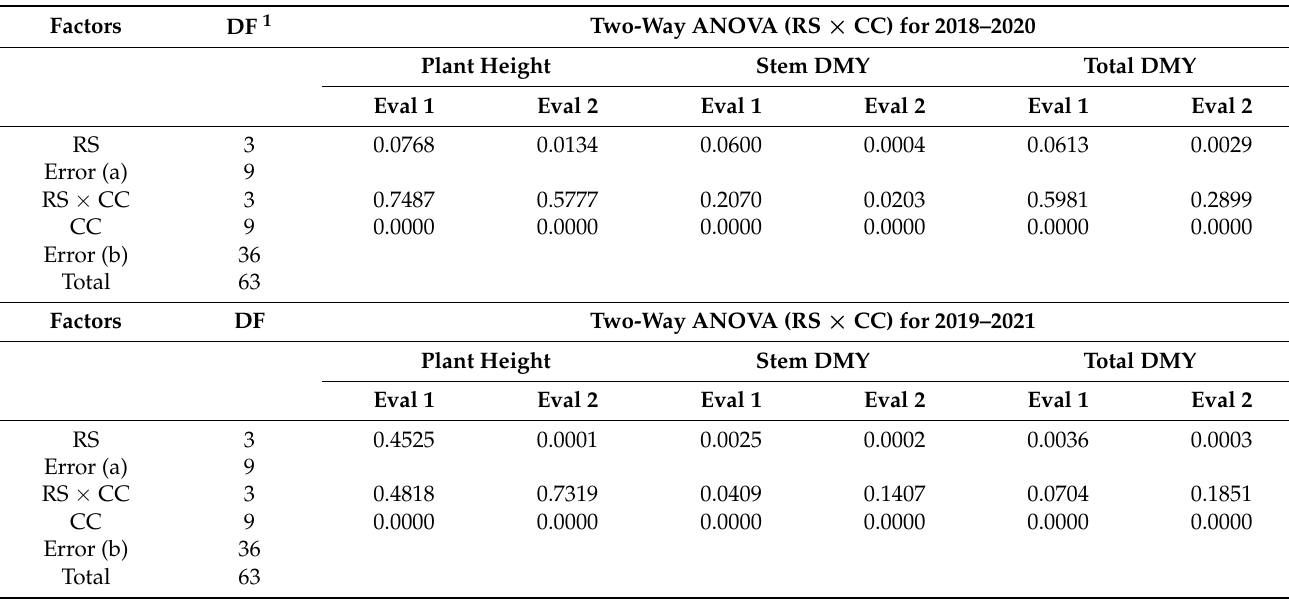
Figure 3. Sulla ( a ) plant height (cm), ( b ) stem DMY (t ha − 1 ), and ( c ) total DMY (t ha − 1 ). Different lowercase letters indicate significant differences. Vertical bars indicate standard errors. DMY; Dry Matter Yield. Table 5. The effects of sulla row spacing and cover crops on sulla plant height, stem DMY, and total analyzed separately for each growing